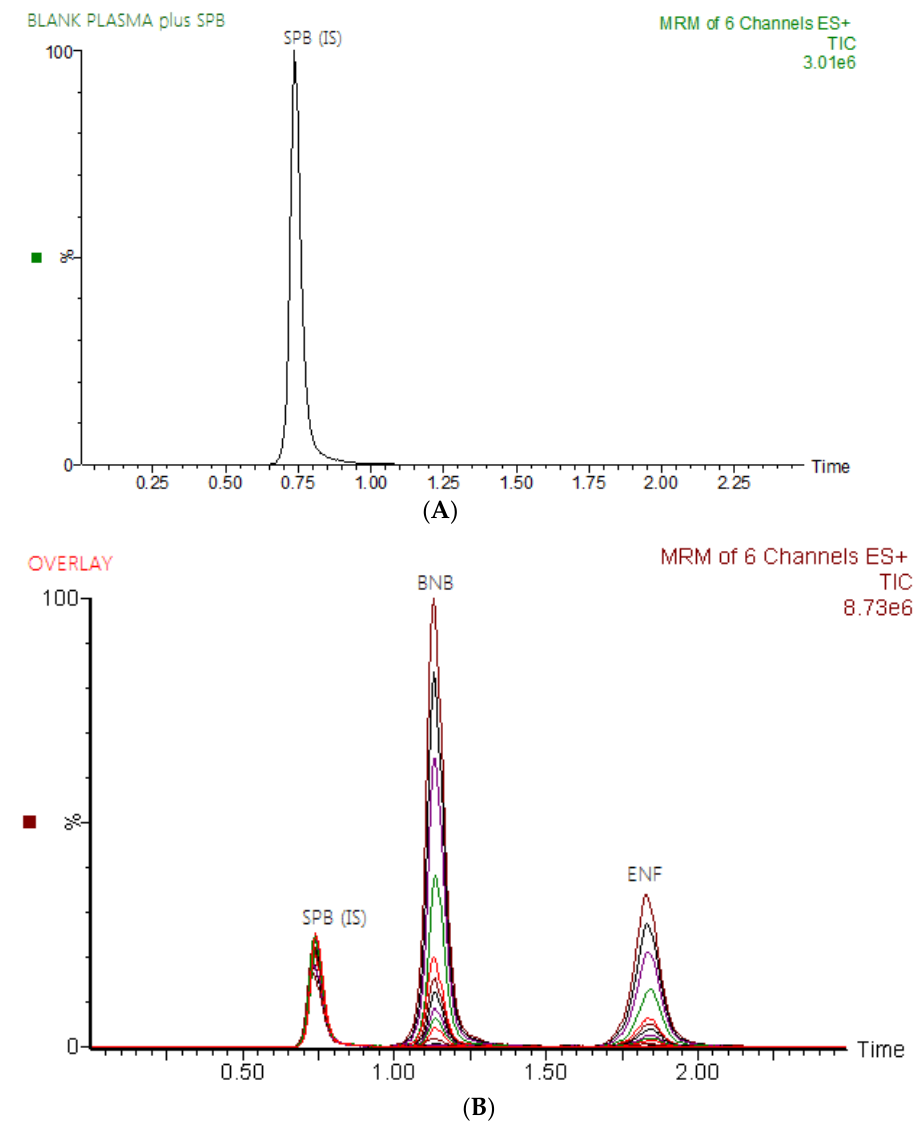
Figure 1. Representative total ion chromatograms for blank rat plasma spiked with spebrutinib (IS) at a concentration of 100 ng/mL ( A ) and overlays of the LC–MS/MS analysis of binimetinib (1.14 min), encorafenib (1.86 min) at concentrations of 0.5–3000 ng/mL and IS (0.73 min) at a concentration of 100 ng/mL ( B ).